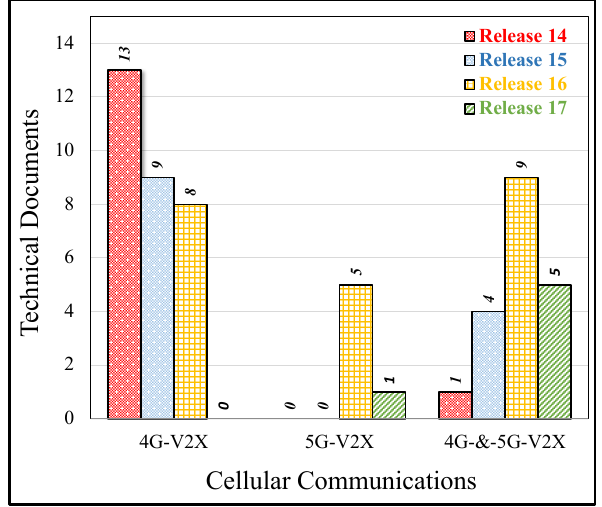
Figure 8. Frequency of technical documents in 3GPP releases (14–17) supporting V2X communication.